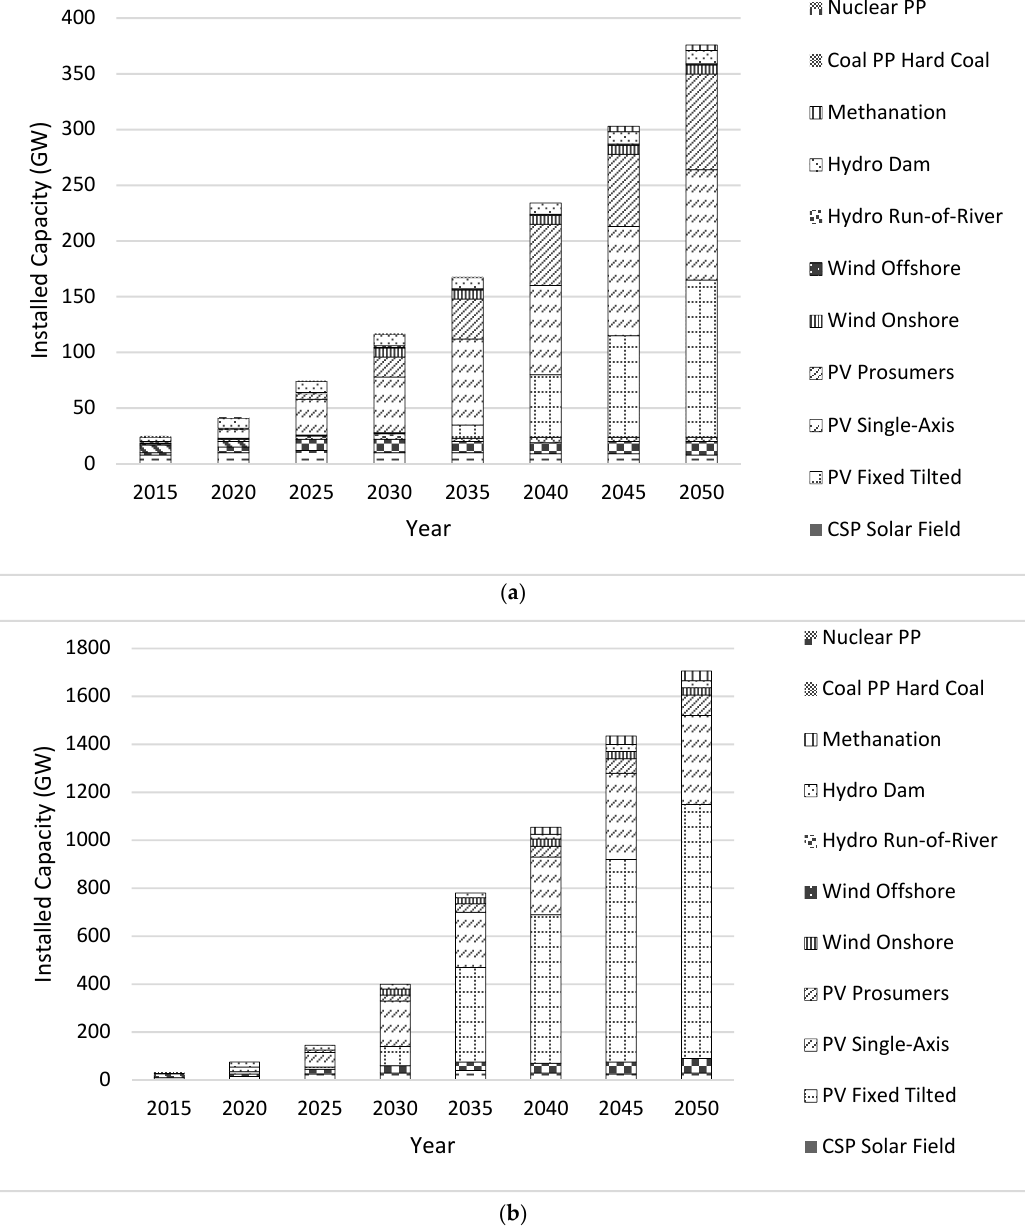
Table 12. Solar PV projects under development with their capacities and estimated COD. Sr.